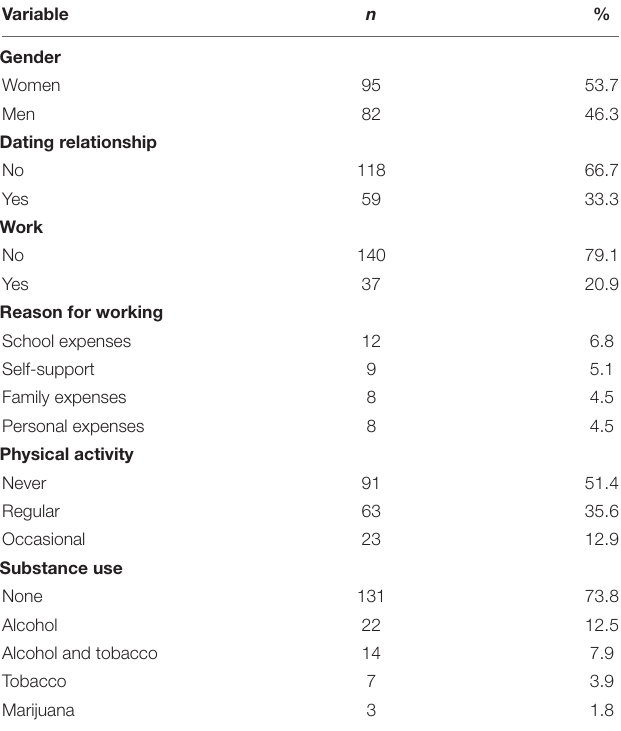
TABLE 1 | General features and life activities of the participants ( n = 177).